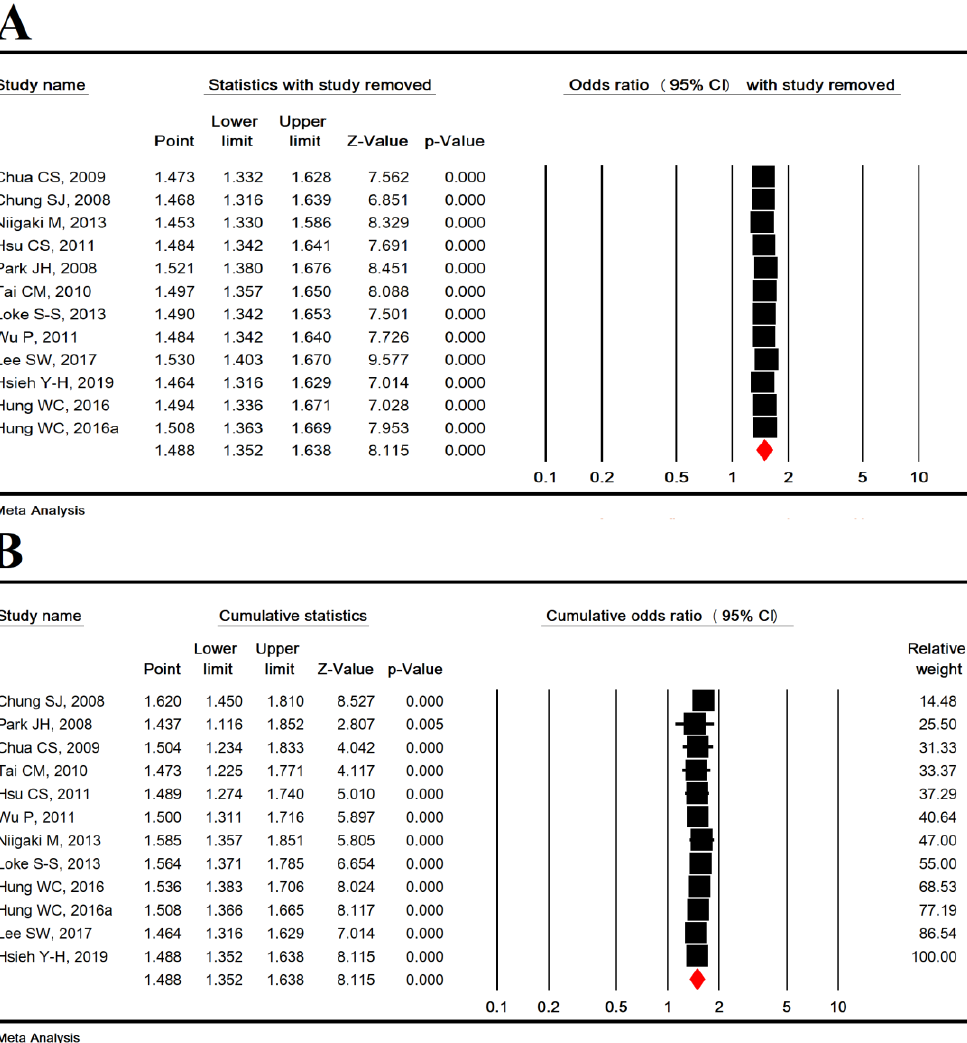
Figure 3: Sensitivity analysis ( A ) and cumulative analysis based on published year ( B